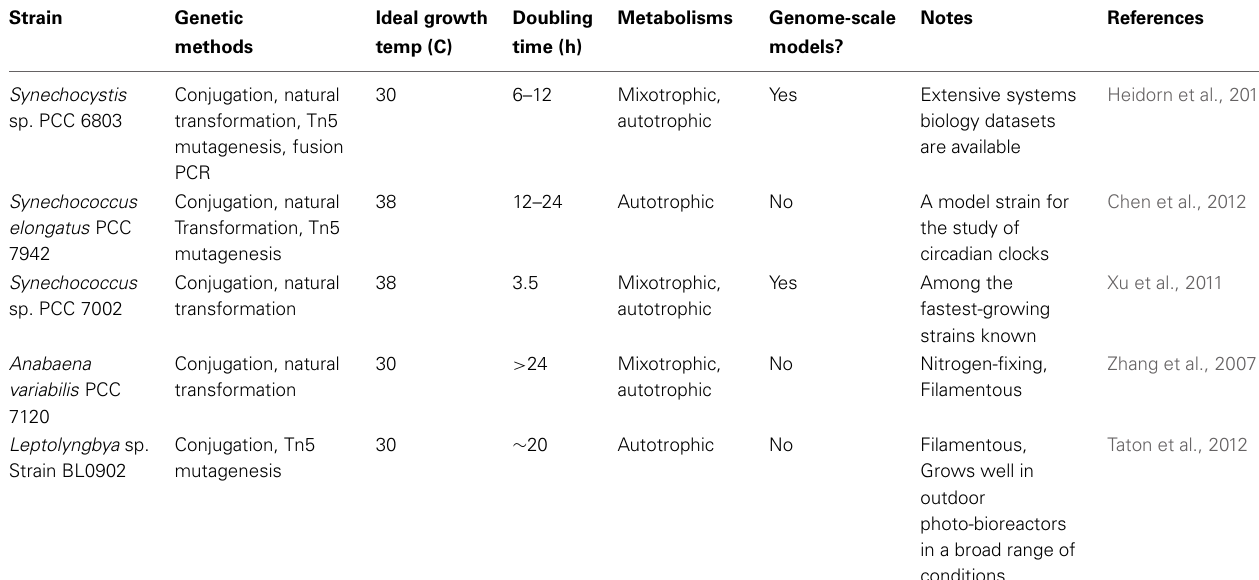
Table 1 | Model strains of cyanobacteria for synthetic biology.